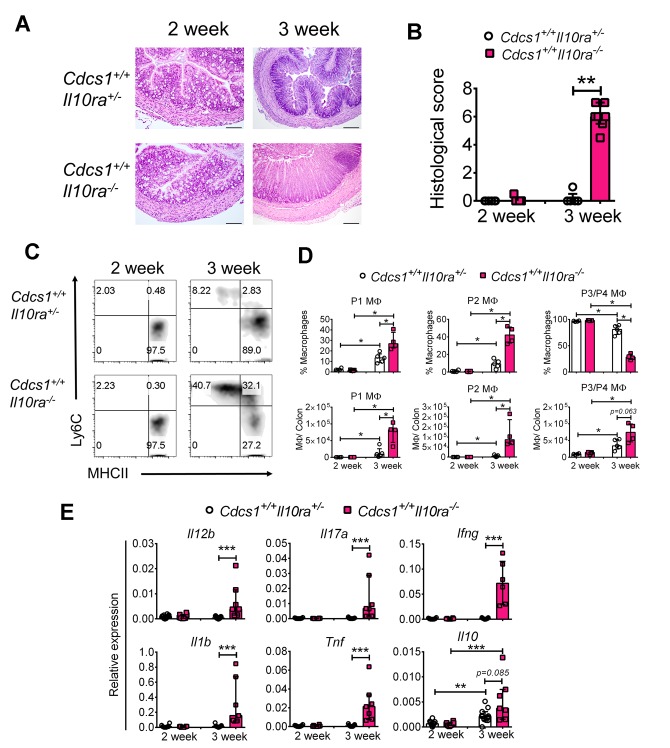
IL10Rα is necessary to prevent intestinal inflammation in infant mice.Il10ra-/- mice (C57BL/6) were crossed with congenic Cdcs1 mice and the development of spontaneous colitis was investigated. (A) Representative histologic images from the colon of Cdcs1+/+Il10ra-/- and littermate Cdcs1+/+Il10ra+/- control mice at indicated ages (bar represents 100 μm for 2 weeks and 200 μm for 3 weeks). (B) Histologic scores from indicated mice; (C) Representative FACS plots of colonic LP MΦ populations, gated on CD45+ CD11b+CD11cintCD103-CD64+ cells. (D) Comparison of the frequencies and numbers of LP MΦ subsets in the colons of mice described. (E) Summary of gene expression analysis by qRT-PCR from the colons of mice indicated above. *p<0.05, **p<0.01, ***p<0.001, Mann-Whitney U test, Median with IQR is shown. Data were pooled from 2 to 3 litters resulting in a total of 4–11 mice in each group.